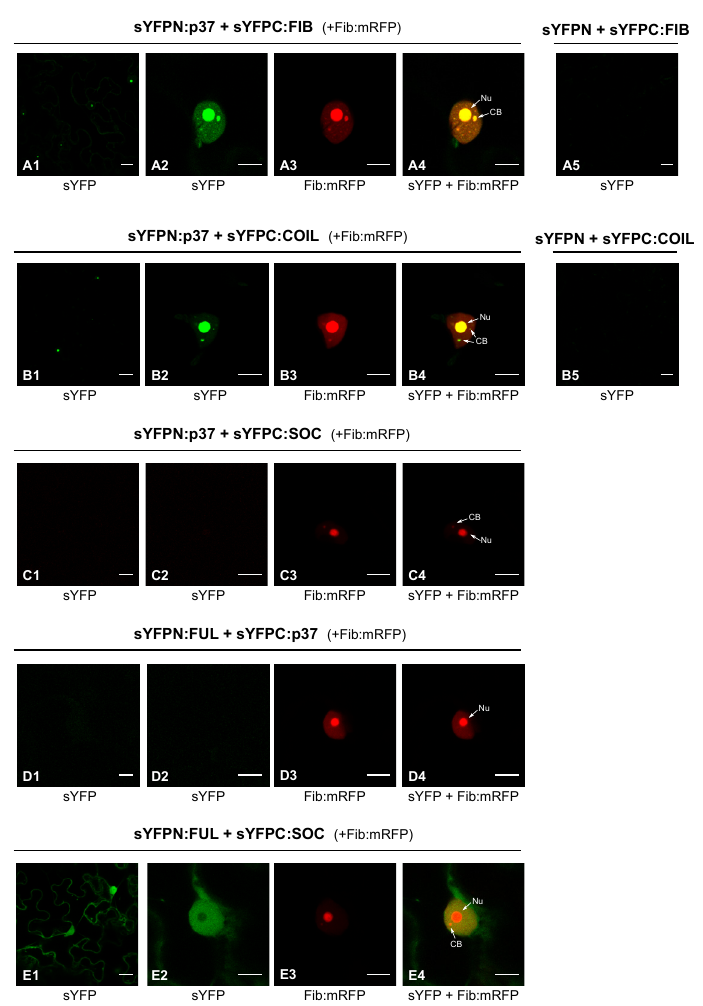
Figure 1. In vivo analysis of p37 interaction with fibrillarin and coilin. WT p37, fibrillarin (FIB), and coilin (COIL) were tagged at their N-terminus with YFP halves (sYFPN and sYFPC) and transiently co-expressed in N. benthamiana leaves to study the protein–protein interactions through a BiFC assay. FIB-mRFP was also co-expressed in these assays as a nucleolar/CB marker. Confocal laser scanning microscopy was used for the observation of fluorescence at 3 dpif. The micrographs ( A1 , B1 ) show a general view of sYFP-derived fluorescence in epidermal cells expressing sYFPN:FIB and sYFPN:COIL, respectively, in combination with sYFPC-tagged p37 molecules; the micrographs ( A2 , B2 ) show a close view of sYFP-derived fluorescence from the same protein-tagged combinations; the micrographs ( A3 , B3 ) correspond to the same close views but record the mRFP fluorescence derived from FIB-mRFP; the micrographs ( A4 , B4 ) show overlays of ( A2 , A3 ) and of ( B2 , B3 ), respectively. Equivalent images were obtained with reverse combinations (sYFPC:FIB or sYFPC:COIL co-expressed with sYFPN- tagged p37 molecule) (data not shown). Negative control combinations (sYFPN-sYFPC:FIB; sYFPN- sYFPC:COIL) are displayed in micrographs ( A5 , B5 ), respectively. Additional negative controls were included and shown in micrographs ( C1 – C4 ), ( D1 – D4 ), and ( E1 – E4 ). These controls corresponded to two transcription factors, FUL and SOC, that interact between them in the nucleus and cytoplasm ( E1 – E4 ) but that did not show interaction with p37 ( C1 – C4 , D1 – D4 ). Nu: Nucleolus. CB: Cajal body. The inset scale bar corresponds to 20 µ m in the first column panels and to 10 µ m in all remaining